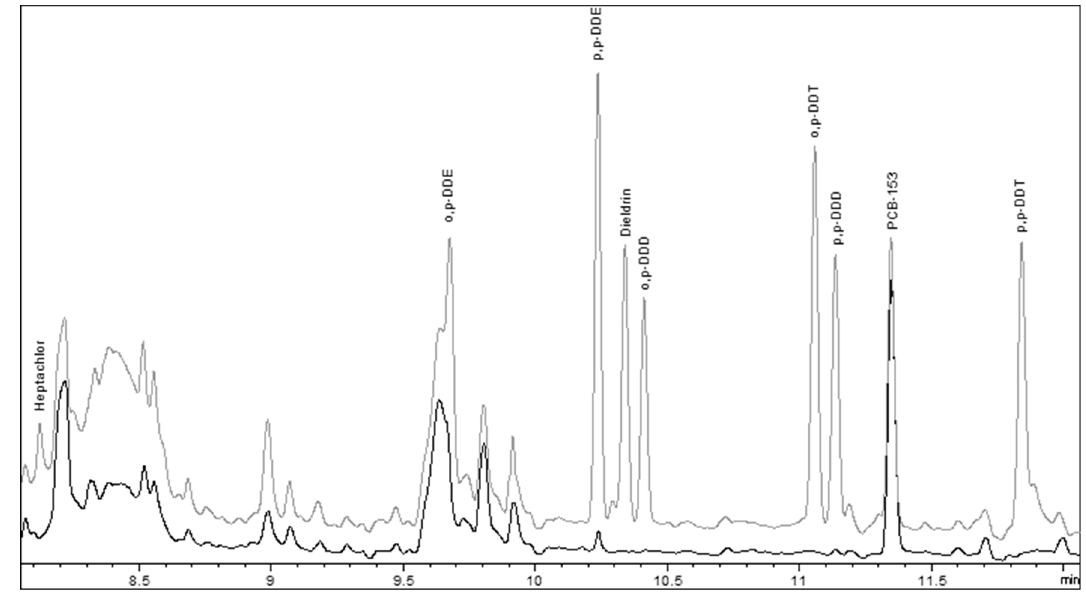
Figure 1. GC-µECD chromatogram of a honey sample fortified with the compounds studied. Figure 1. GC- µ ECD chromatogram of a honey sample fortified with the compounds